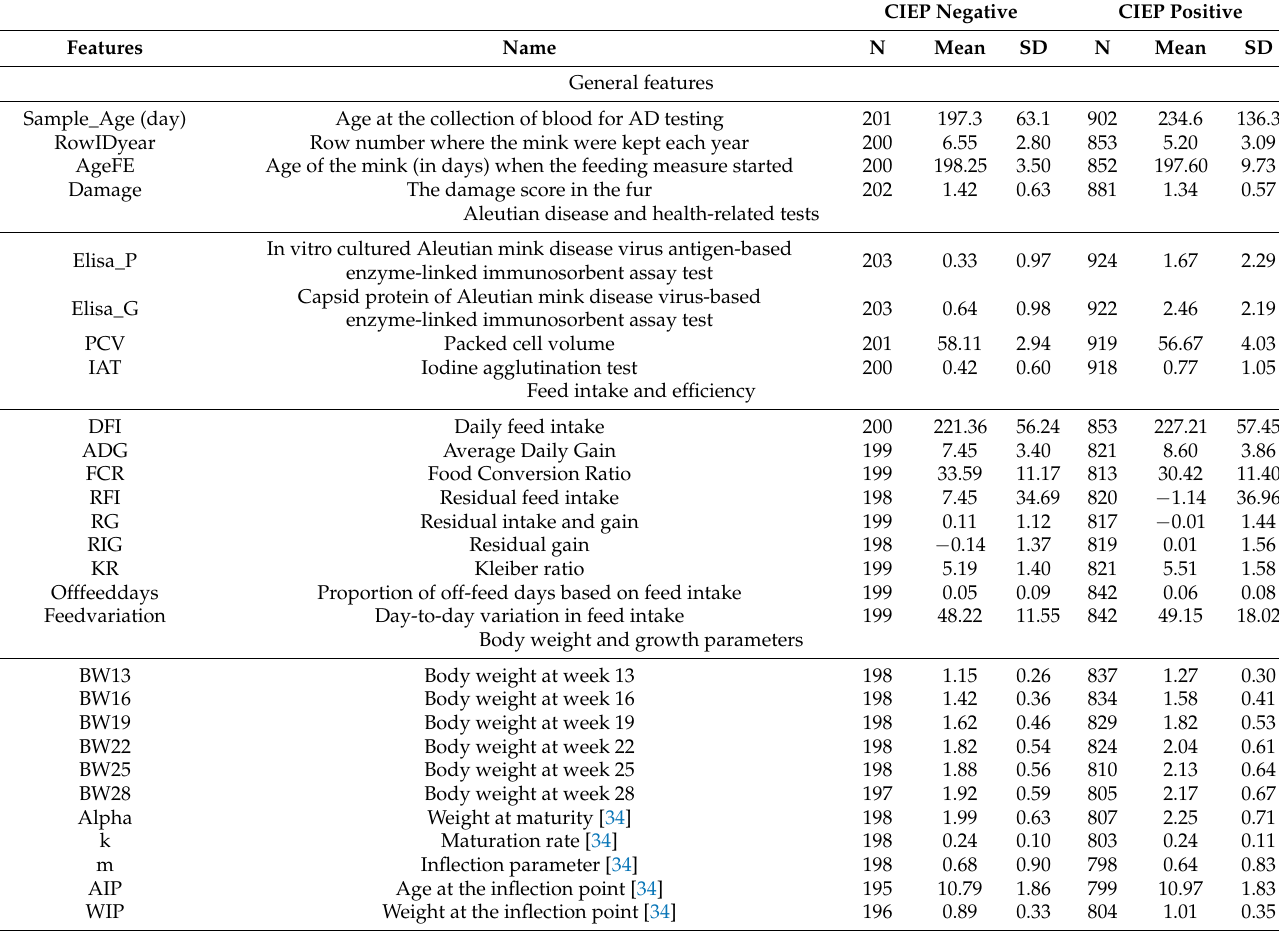
CIEP Negative CIEP